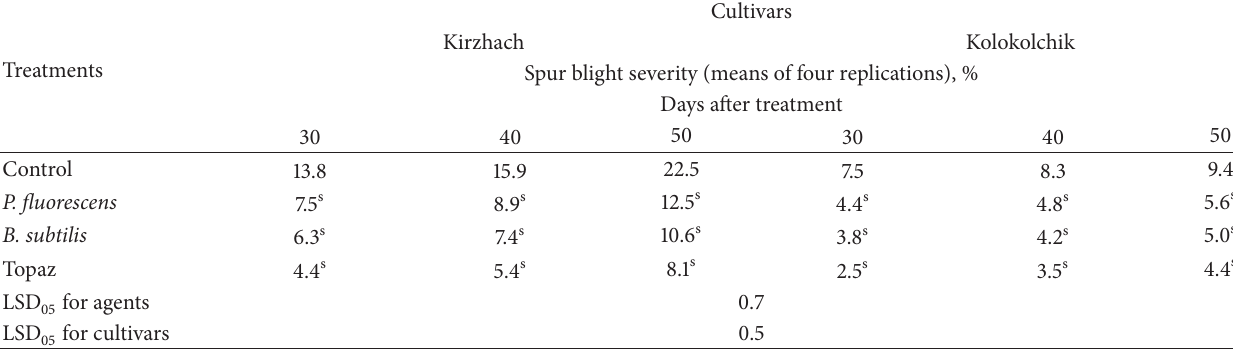
Table 6: Effect of the biocontrol agents on raspberry spur blight severity a , 2014.